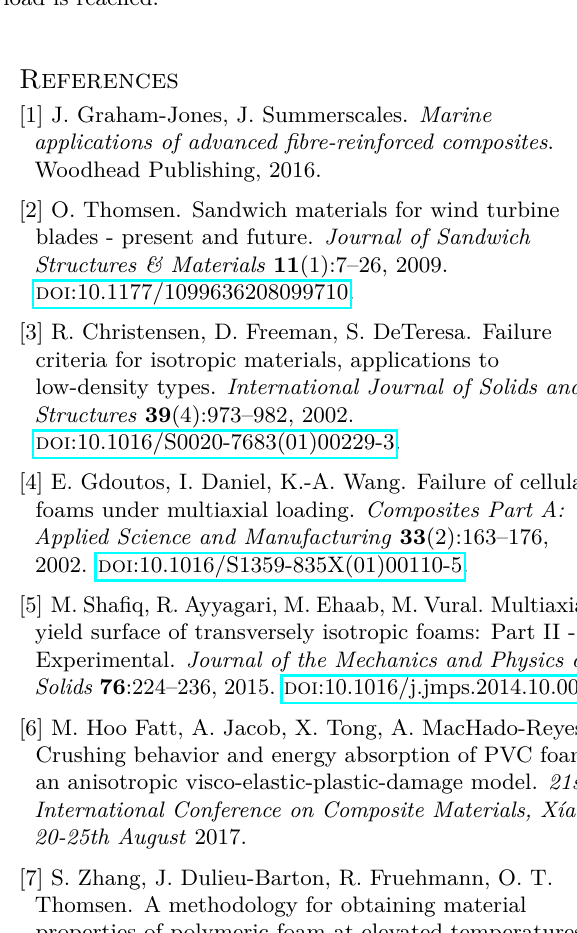
Figure 5. Local Lagrangian shear strain fields with the corresponding global shear strain values γ of a simultaneous tensile-torsion test, in which the 50% of the tensile failure load is